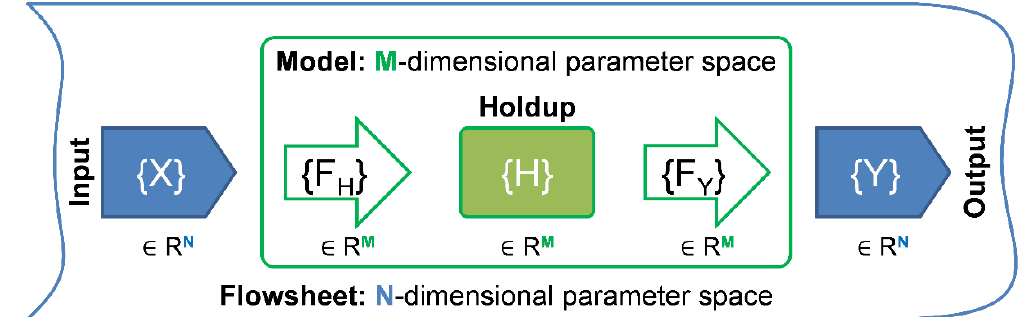
Figure 1. Simplified scheme of embedding a model into a flowsheet.